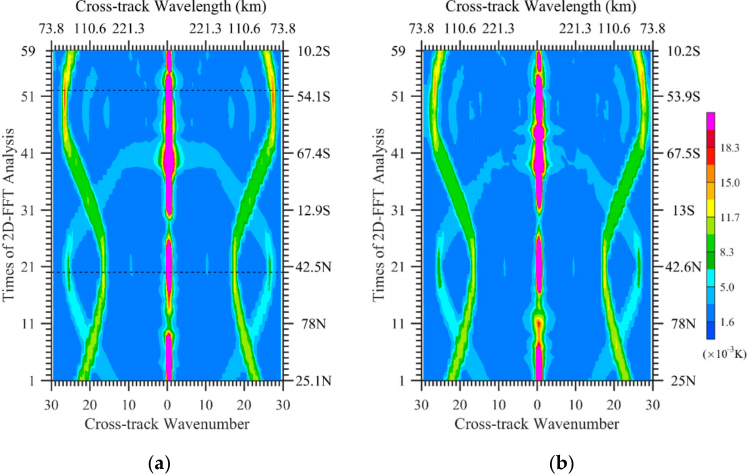
Figure 8. Variations of the amplitude averaged over along-track wavenumbers 1–150 with respect to the cross-track wavenumber for TB observations over the two swaths shown in Figure 3: ( a ) the swath with its observation times from 1915 to 2057 UTC (black-curved edges) and ( b ) the other swath whose observation times were from 2057 to 2238 UTC (dash-curved edges). The 2D FFT with 300 scanlines each time is carried sequentially with an overlap of 50 scanlines between two neighboring portions of the 2D Fourier analysis domain.